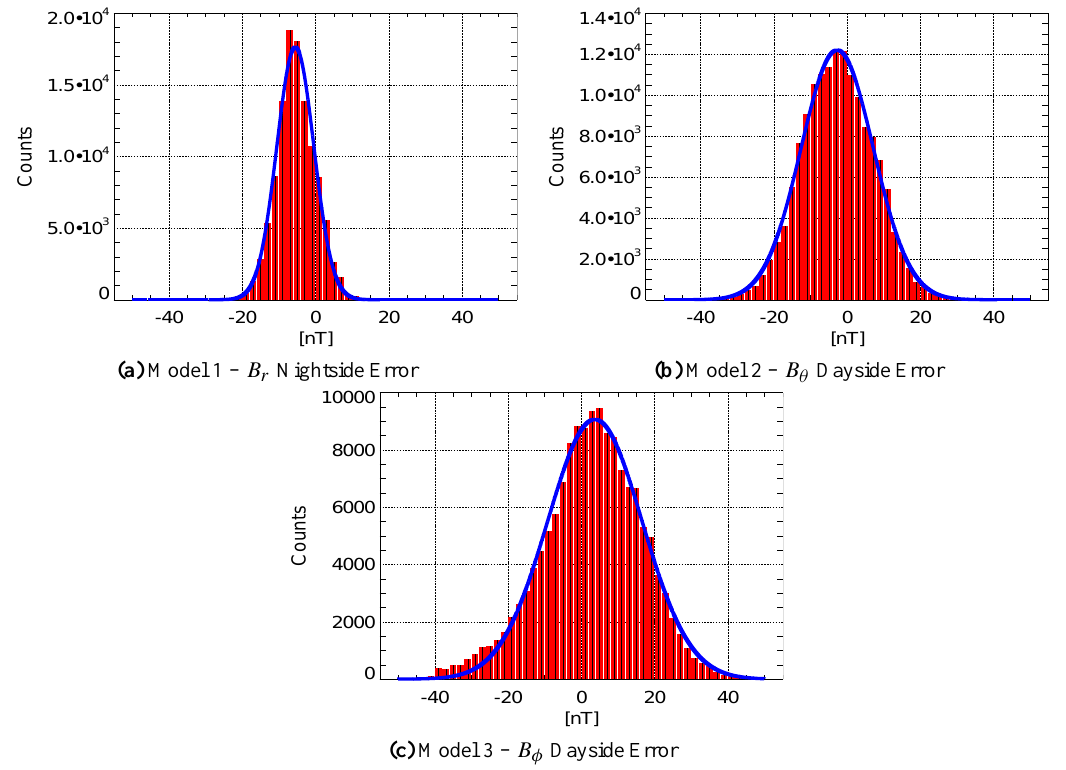
Fig. 10. A sampling of the error distributions with Gaussian fits for different model components in units of counts per 2nT bin.